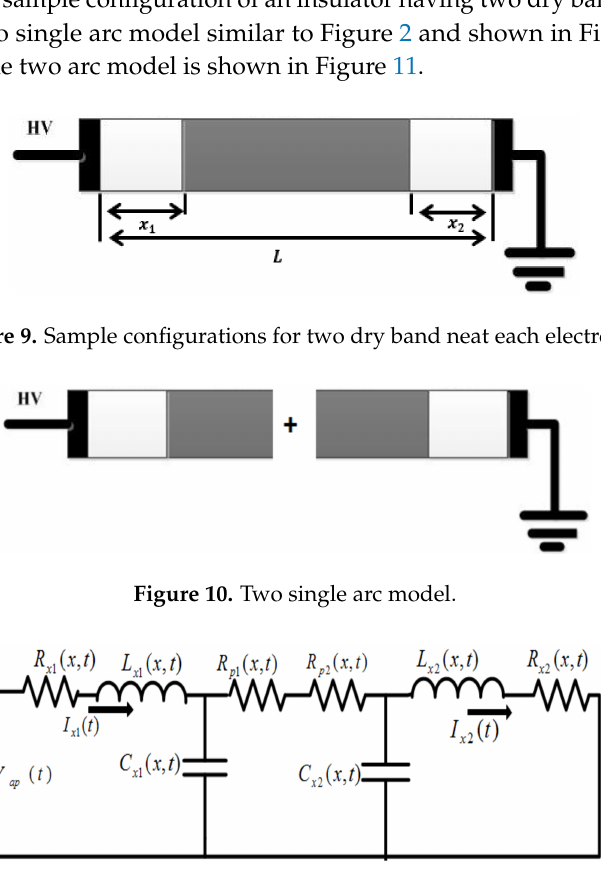
Figure 11. Electrical equivalent circuit of two arc